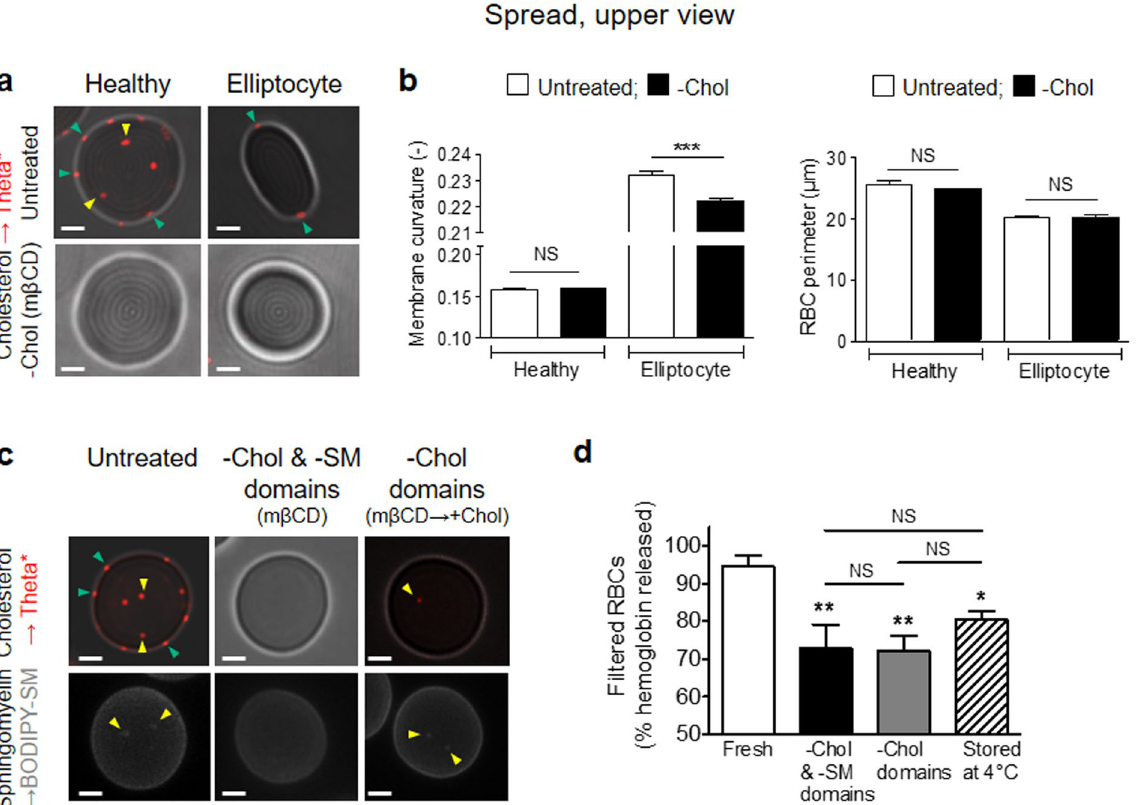
Figure 5. Loss of high curvature areas in elliptocytes and impairment of healthy RBC deformability upon chol-enriched domain abrogation. ( a,b ) Relation between lipid domains and RBC curvature. Fresh healthy and elliptocytotic RBCs were either left untreated ( untreated ) or incubated with methyl-ß-cyclodextrin (mßCD, -Chol ), then labelled with Theta * , washed, spread and observed as in Fig. 1. ( a ) Representative imaging of four independent experiments. Y ellow and green arrowheads indicate respectively LC and HC membrane areas, scale bars 2 µ m. ( b ) Quantification of membrane average curvature and RBC perimeter of untreated ( open bars ) and treated ( black bars ) healthy and elliptocytotic RBCs. ( c,d ) Relation between lipid domains and RBC deformability. Fresh healthy RBCs were either left untreated (untreated) or incubated with mßCD ( -Chol & -SM domains ) or mßCD followed by chol repletion ( -Chol domains ), or maintained at 4 °C during 2 weeks to accelerate aging ( Stored ). All preparations were then labelled with Theta * or BODIPY-SM, washed, spread and observed as in Fig. 1. ( c ) Representative imaging of three independent experiments. Y ellow and green arrowheads indicate respectively LC and HC membrane areas, scale bars 2 µ m. ( d ) RBC filtration. The amount of RBCs that passed through the filter was measured by haemoglobin release after complete RBC lysis and expressed as percentage of the amount of RBCs before filtration. Results are means ± SEM of 6–8 filtrations from 2–4 independent experiments. Statistical significance was tested with one-way ANOVA followed by Tukey’s post-hoc